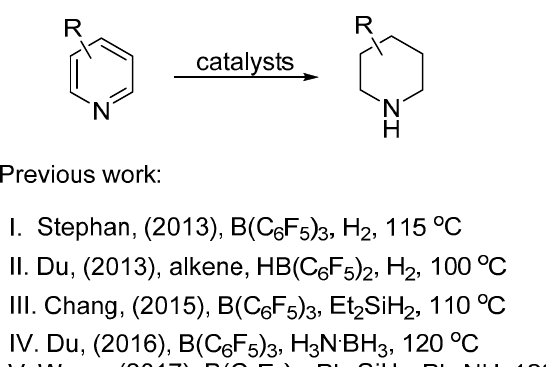
Figure 1. Selected examples for the synthesis of piperidines through the catalytic reduction of pyridines.